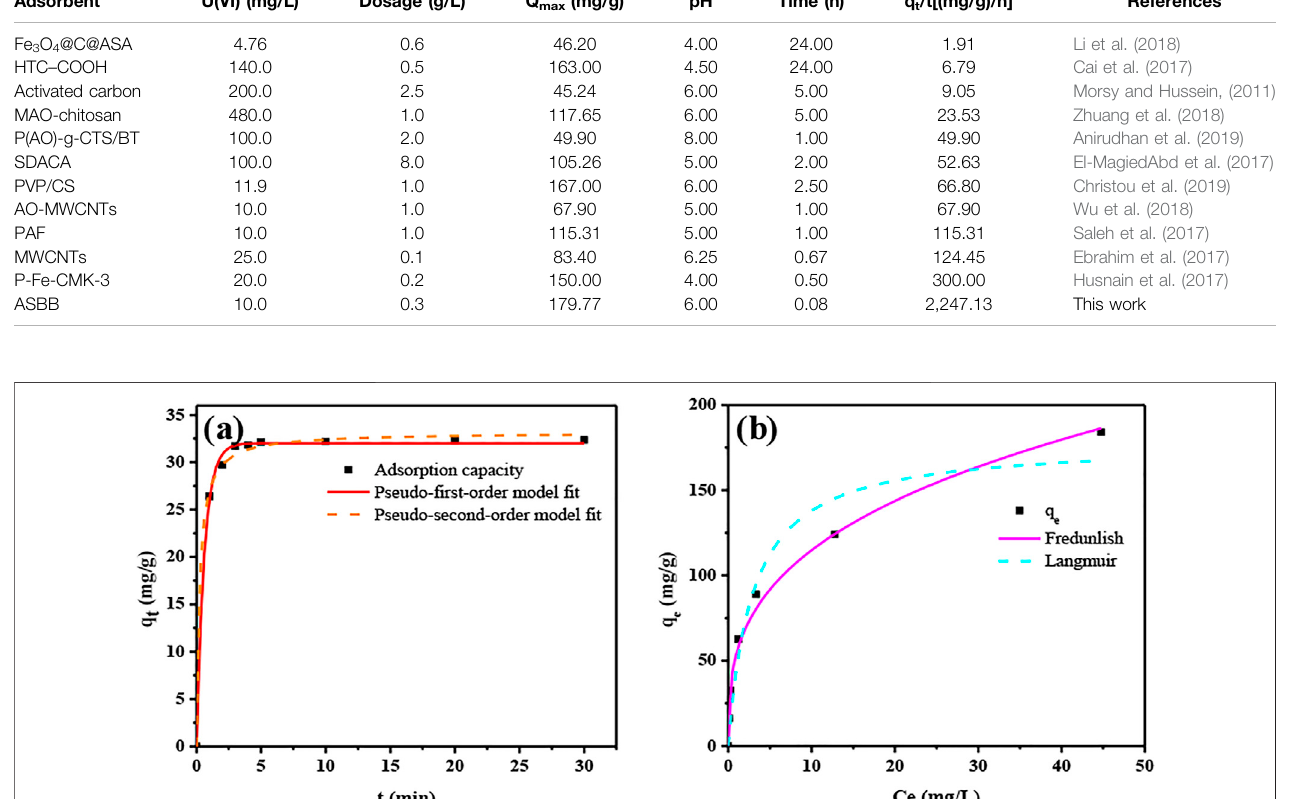
TABLE 2 | Comparison of the maximum sorption capacities of different adsorbents toward U(VI). Adsorbent